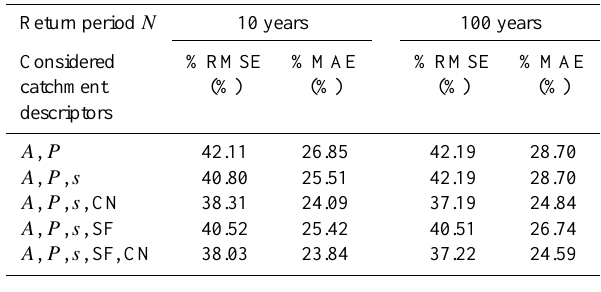
Table 2. Values of %RMSE and %MAE for all considered combi- nations of involved catchment descriptors.